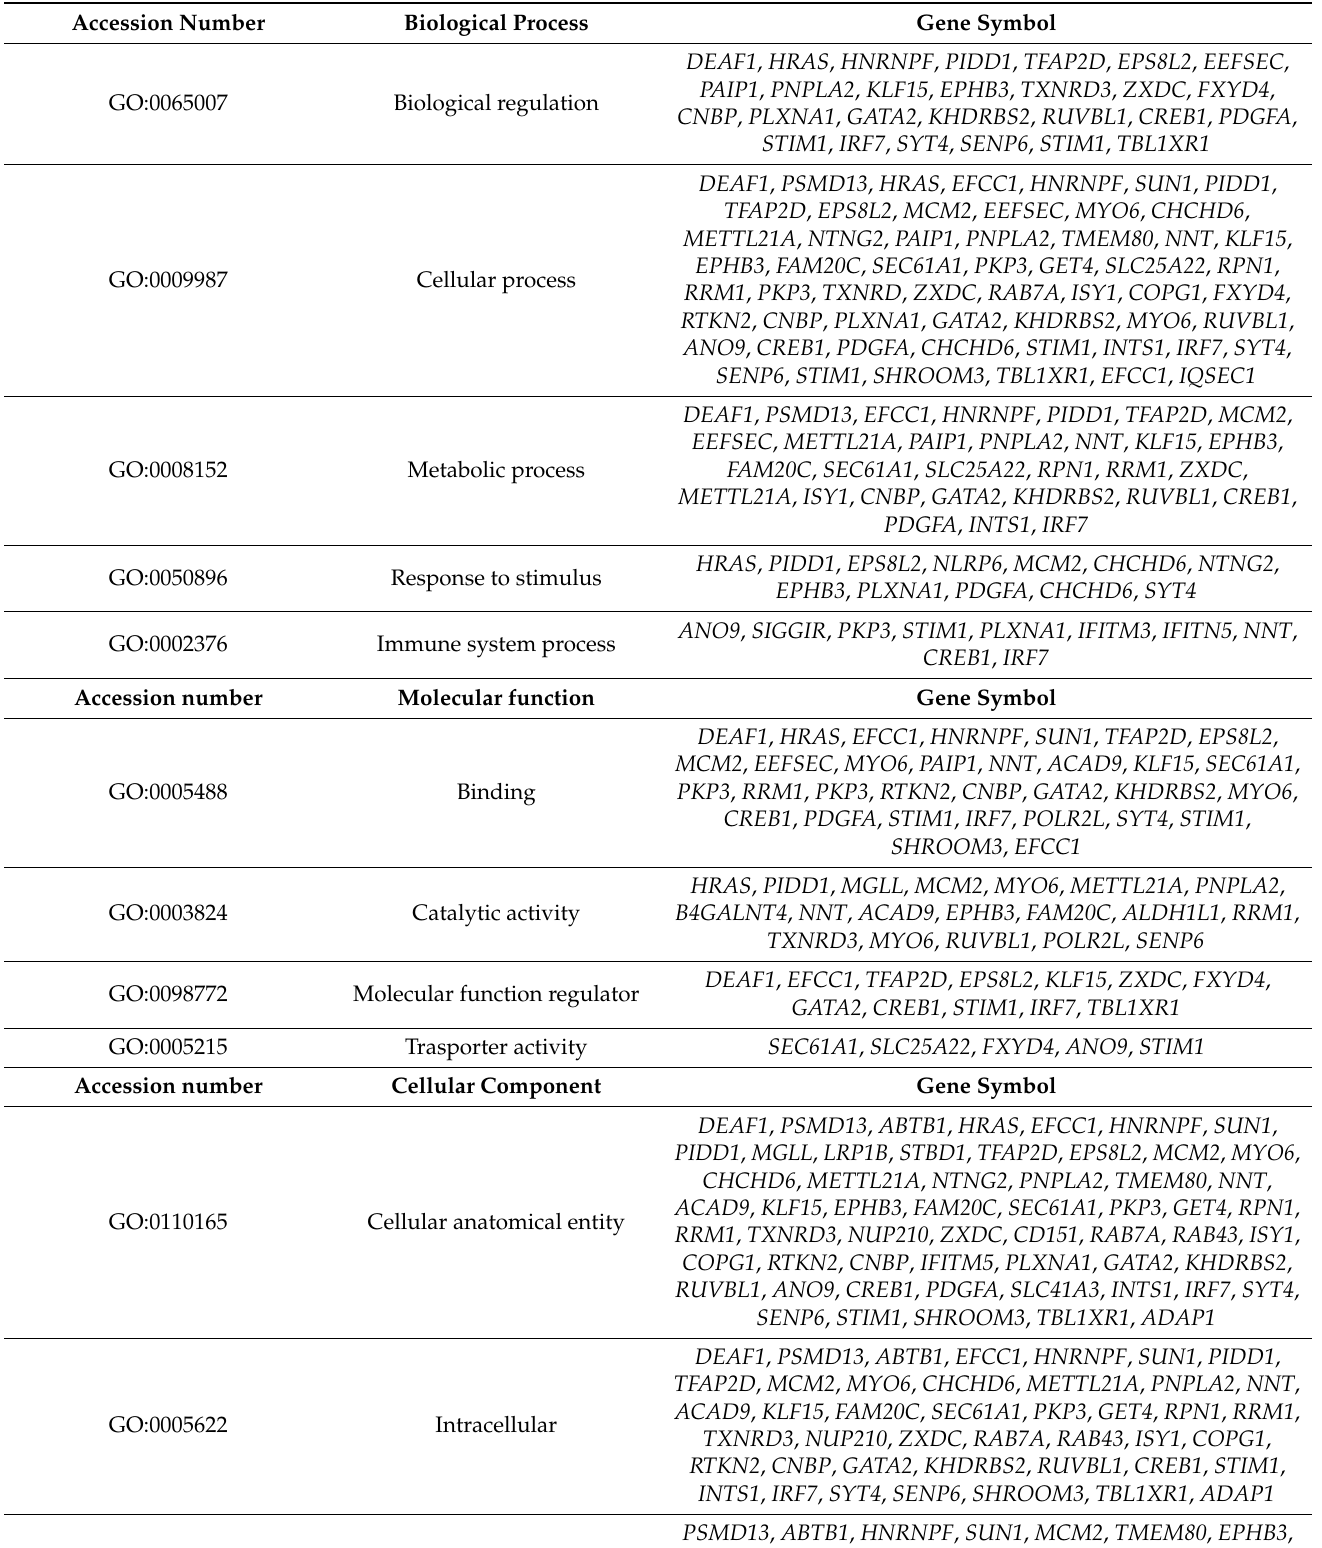
Table 4. The gene ontology (GO) in the CNVRs identified in the five sheep